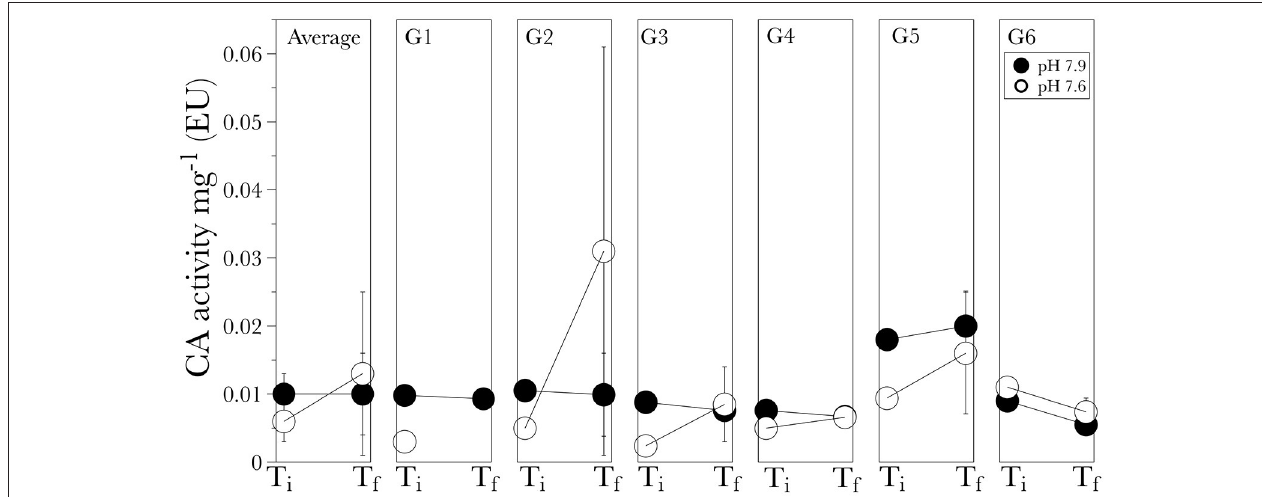
FIGURE 5 | Carbonic anhydrase activity for the long-term experiment shown for the average of all genotypes (general) and for individual genotypes (G1 through G6). T i is the initial time point and T f is the final time point after the six-month experiment. Values are given as mean ± S.D .